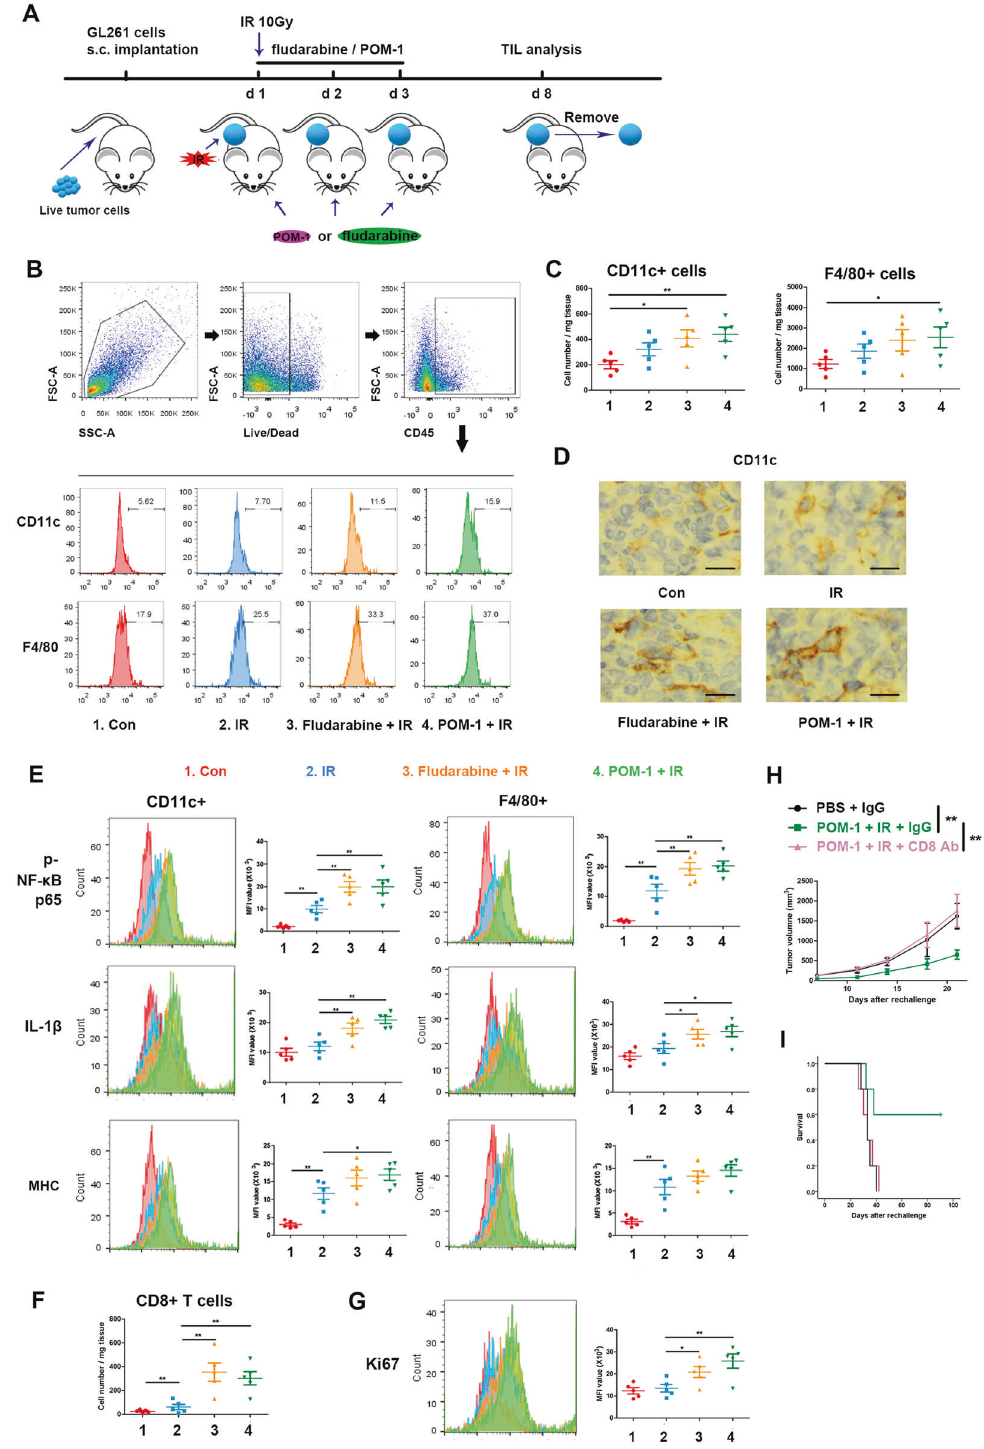
Fig. 4 STAT1 or CD39 inhibition enhanced in fl ammasome activation of mononuclear phagocyte system in TME following IR. Subcutaneous tumors of C57BL/6 J mice were irradiated after mice were administrated with PBS, fl udarabine, or POM-1, then were removed to prepare single-cell suspensions. Cells were stained for surface markers, then fi xed and permeabilized for intracellular staining. Flow cytometry was used for markers measurement. A The schedule of treatment for mice is showed. B Representative plots showing the general gating strategy to delimit the positive CD45 cells from tumor tissue and positive CD11c and F4/80 cells in CD45 + T cells. C Positive CD11c and F4/80 cell number. D Positive CD11c cells were analyzed using IHC, and Images were captured with a light microscope (×400). Scale bars correspond to 20 μ m. E The levels of phospho-NF- κ B p65, IL-1 β , and MHC in CD11c + or F4/80 + cells. F Positive CD8 cell number. G The levels of Ki67 in CD8 + cells. H , I The mice were removed from the untreated or IR + POM-1-treated tumors. were injected with live GL261s cells on the other side, and administrated with or without CD8 antibody. H the rechallenged tumor size was measured. I The survival of mice was recorded. * P < 0.05, ** P < 0.01.